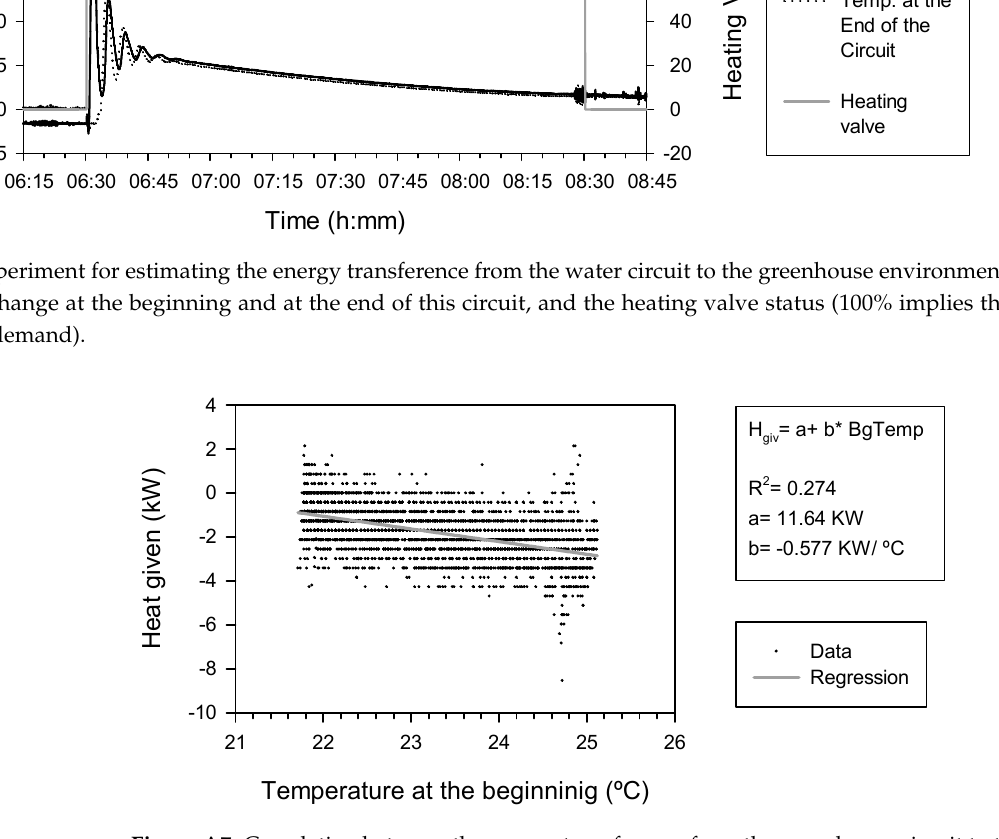
Figure A8. A heating experiment to estimate the combustion efficiency using continuous data (considering also the heat transference from the greenhouse circuit to its environment). Appendix C. Results and Discussion—Additional Considerations Appendix C.1. Flue-Gas Temperature and [CO 2 ] The values observed for these parameters are presented in Figure 5. Focusing on each biomass type, the combination of air/fuel rates and turbulence had an important impact on this variable. The fuel rate is the clearest relationship observed, the higher this rate, the higher the temperature. Regarding the primary air supply, the temperature increased along with this factor. The secondary air supply was not so important; this factor’s impact was less on some configurations. The highest values observed were for the same configurations using pine pellets. There were particularly low values for some configurations, as was the case using the tomato-crop biomass, and the blend of this with almond prunings. Here, the main stages of combustion might have been dehydration and/or devolatilization (the stages occurring at lower temperatures). The secondary air supply had more impact on the configurations for these two biomasses. With regard to CO 2 , the values observed for these parameters are presented in Figure 5. Here, there seems to be a relationship between the fuel supply and the CO 2 concentra- tion: the higher the first is, the higher the second. This increase was more evident in the case of pine pellets and olive pits. Conversely, this relationship was less clear for the other